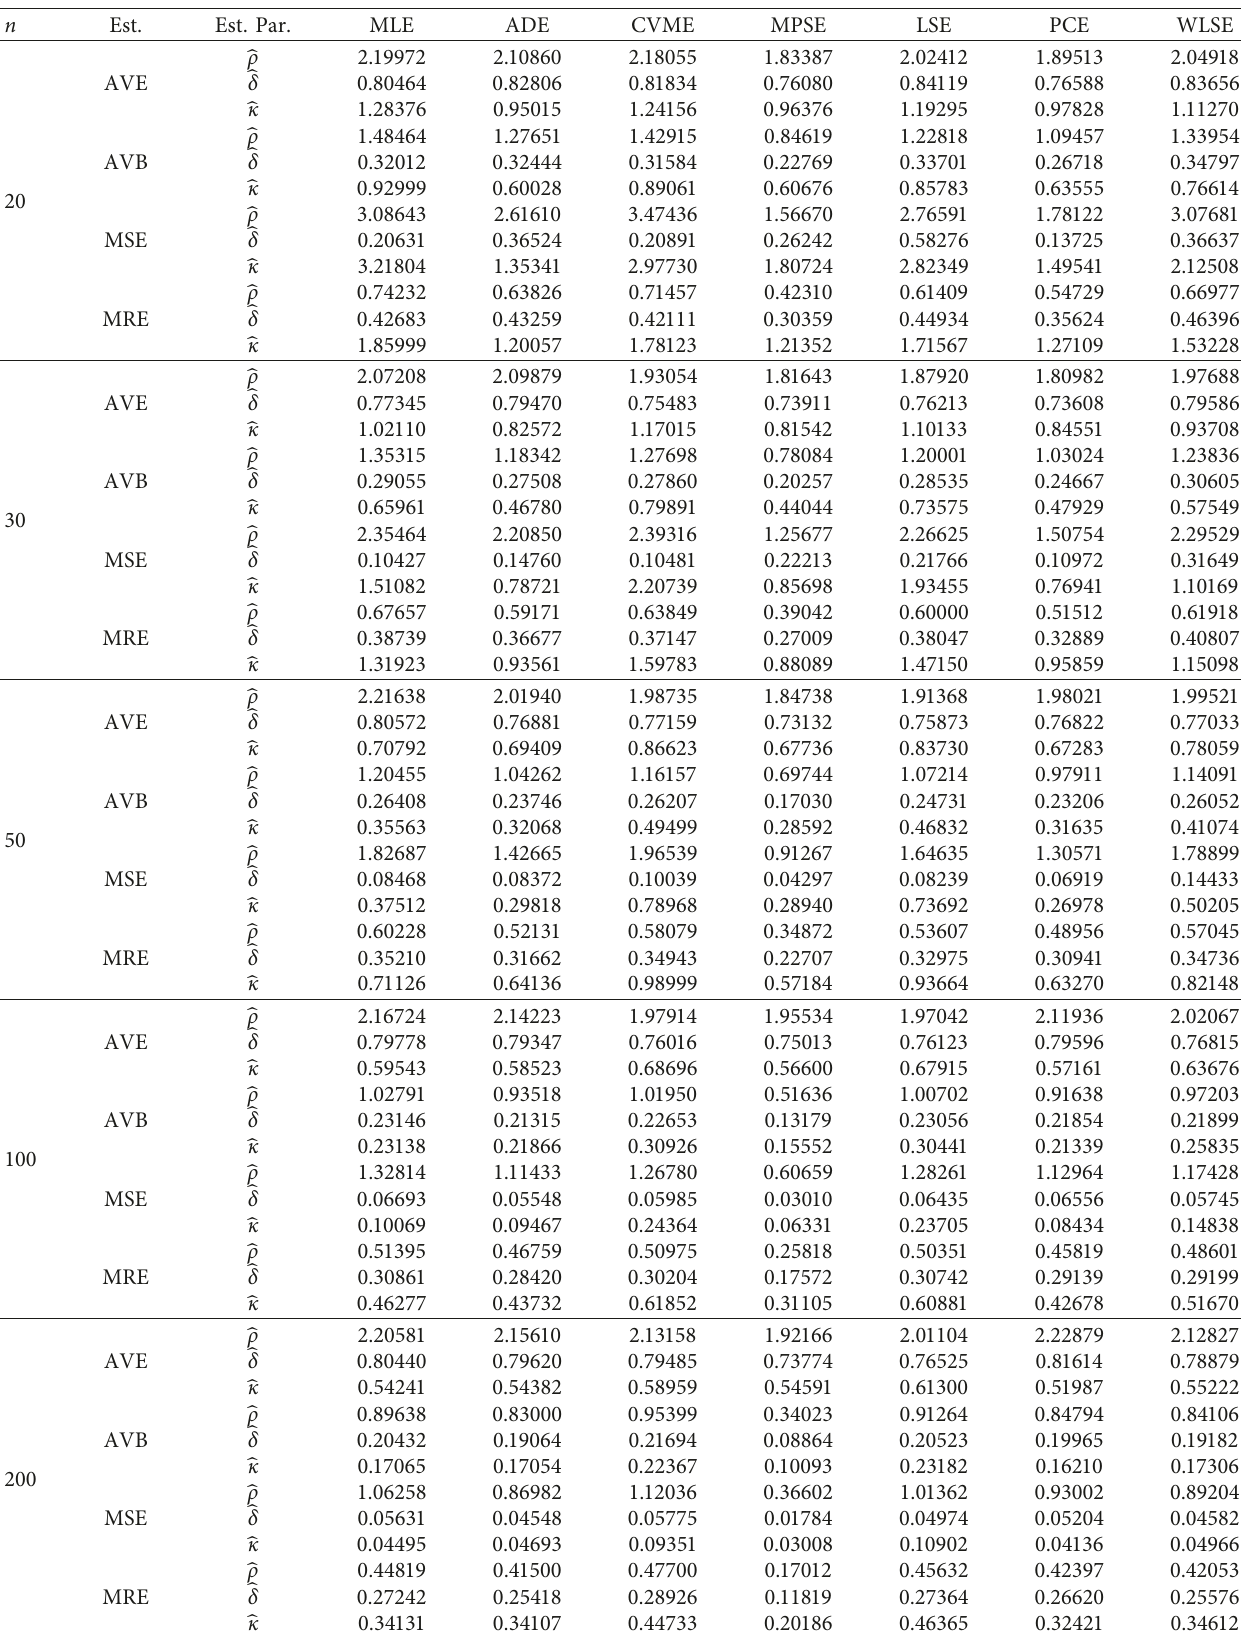
Table 4: Simulation results of the AVE, AVB, MSE, and MRE of BXLE distribution for ( ρ � 2 , δ � 0 . 75 , κ � 0 . 5 ) . n